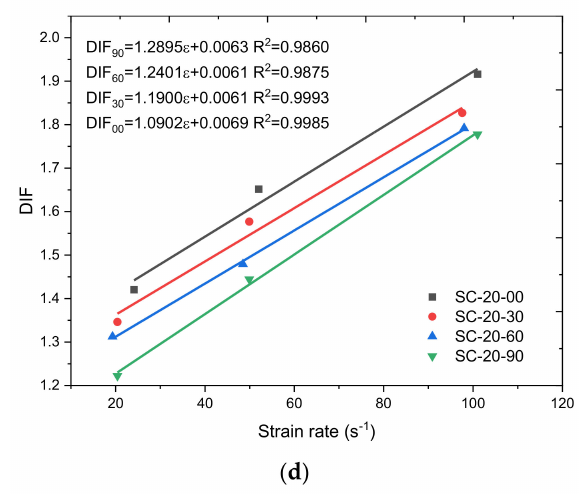
Figure 7. DIF profiles of steel fiber-incorporated concrete under different corrosion durations, ( a ) fiber